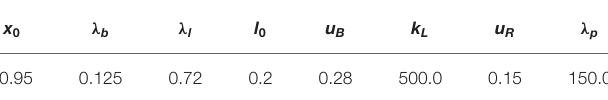
TABLE 2 | Non-dimensional parameters for the simulation with an initial surface obtained from image data, which we report on in section 5.4. x 0 λ b λ